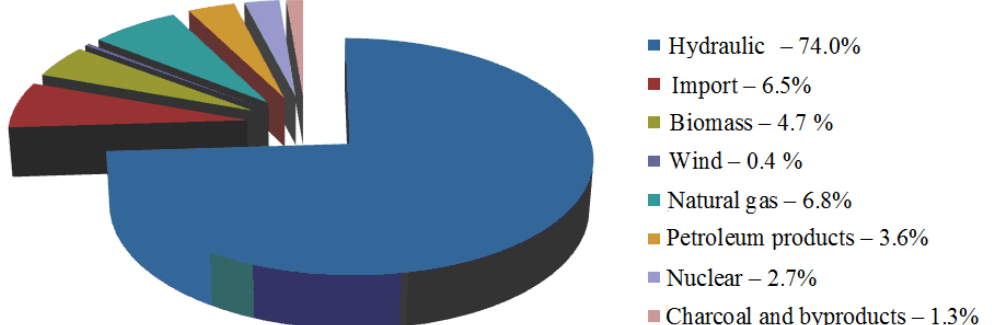
Figure 2. Domestic supply of electricity in Brazil in 2010